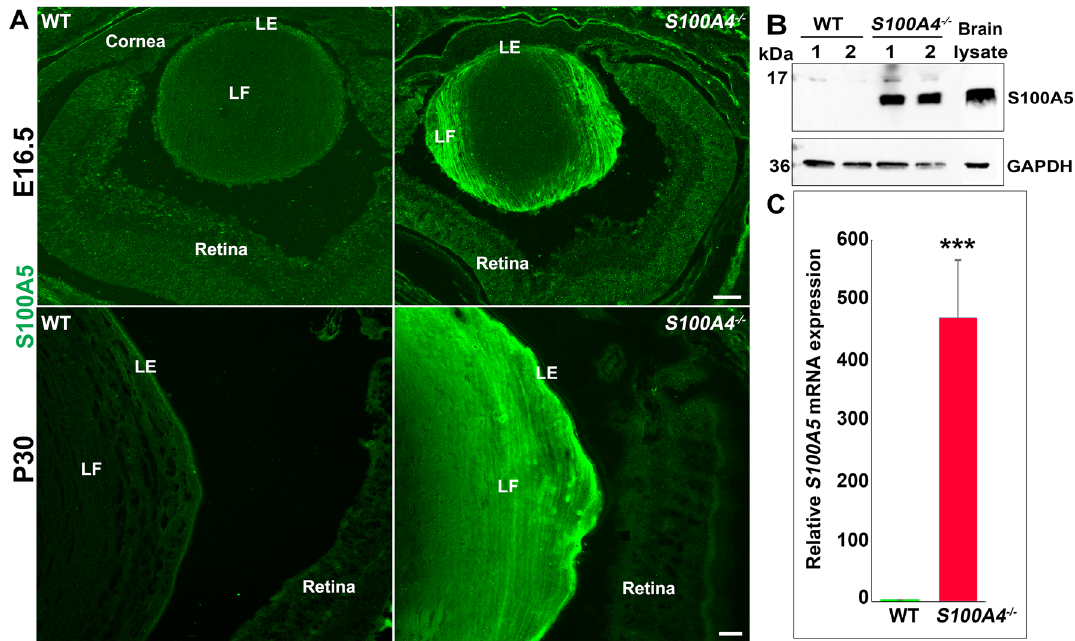
Figure 4. Robust induction of S100A5 gene expression and protein levels in mouse lenses lacking S100A4. ( A ) Immunofluorescence analysis of S100A4 −/− lens sagittal cryofixed sections derived from the E16.5 and P30 mice reveals induction of S100A5 protein, distributing (bright green stain) discretely to the fiber cells in comparison to its absence in littermate WT lenses. Similar to S100A4 (Fig. 1), S100A5 is not detectable in non-lens tissues of the eye. Data represent results from three biological replicates. LE lens epithelium, LF lens fibers. Scale bars 50 and 20 μm for E16.5 and P30 specimens, respectively. ( B ) Immunoblotting analysis based confirmation